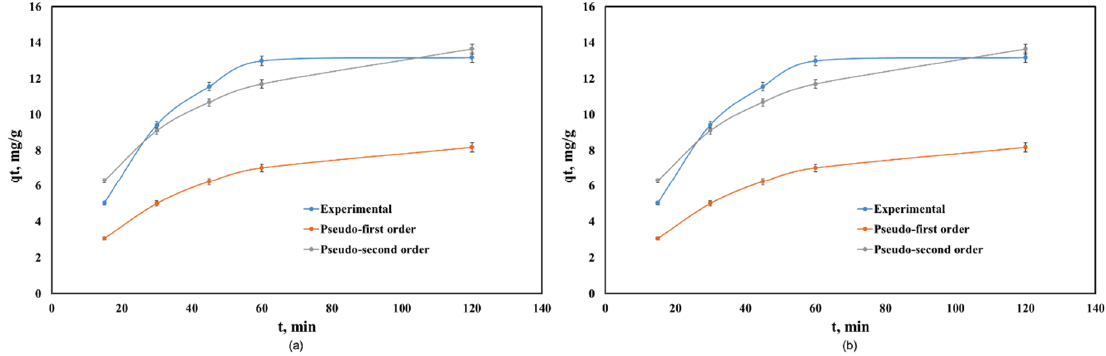
Figure 4. Kinetics of Cd(II) adsorption onto: ( a ) Co–Gly and ( b ) Ni-Gly. Table 2. Kinetic and statistic parameters for the kinetic models.